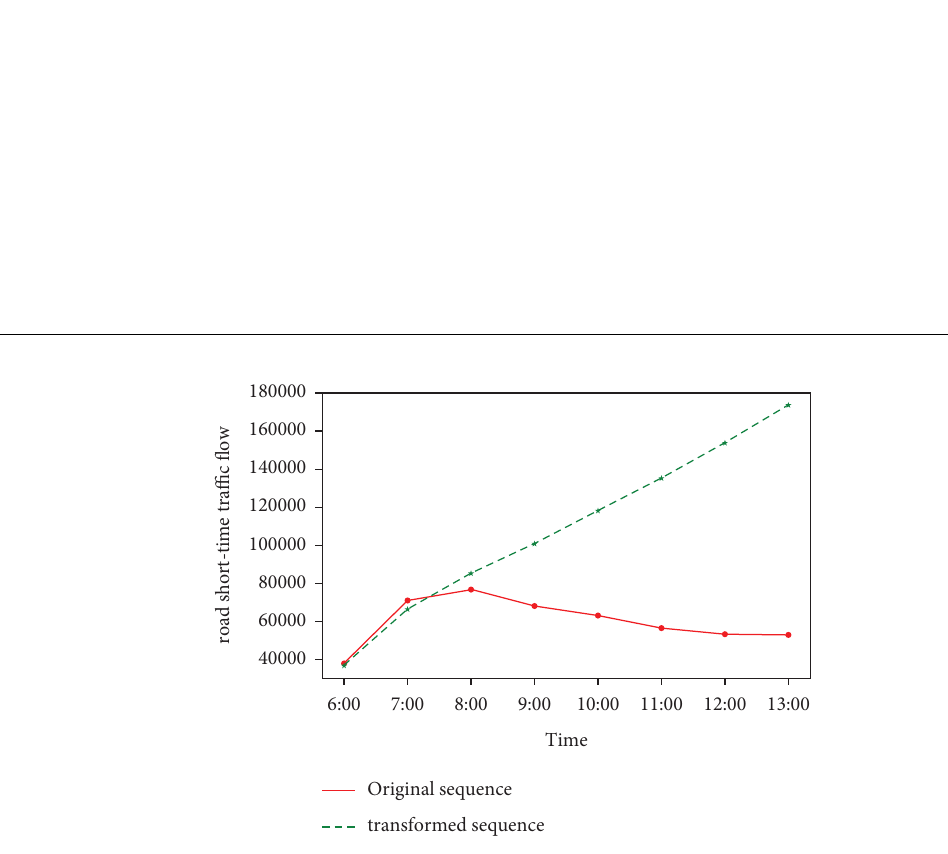
Figure 8: Schematic diagram of the original stochastic oscillation sequence and transformed sequence.